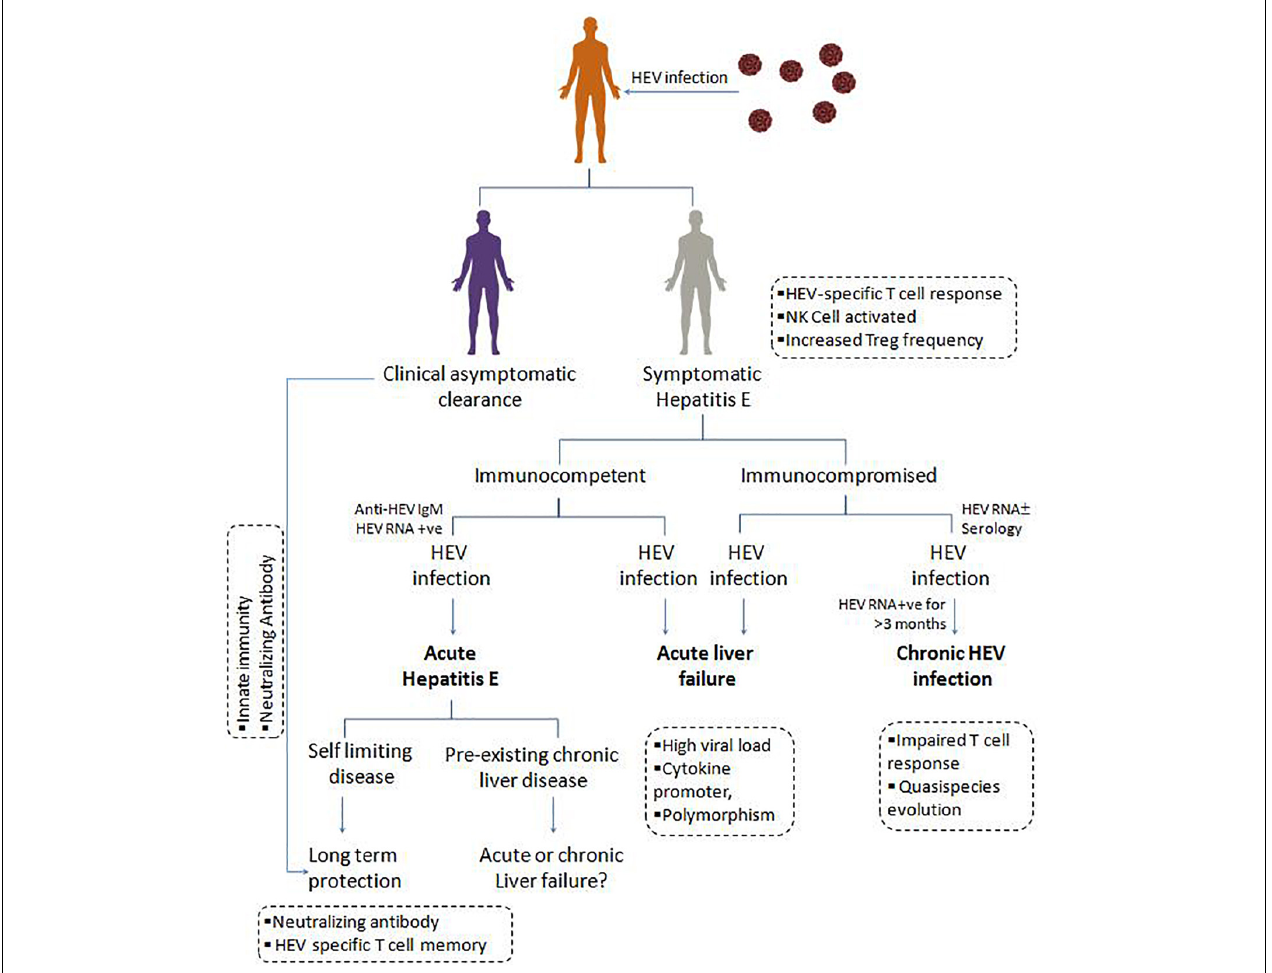
FIGURE 3 | Clinical manifestations, and immune response in HEV infection: On contact with the hepatitis E virus, individuals may undergo asymptomatic clearance owing to innate immunity and neutralizing antibody. Symptomatic immunocompetent and immunocompromised individuals with hepatitis E viral infection present as acute hepatitis E, which is usually a self-limiting form of disease providing long term protection due to HEV specific T cell memory and neutralizing antibody. Acute liver failure due to high HEV load and associated inflammatory cytokines. In immunocompromised patients, the presence of HEV RNA for more than 3 months, results in chronic HEV infection, possibly attributed by the quasi-species evolution in HEV and impaired T cell